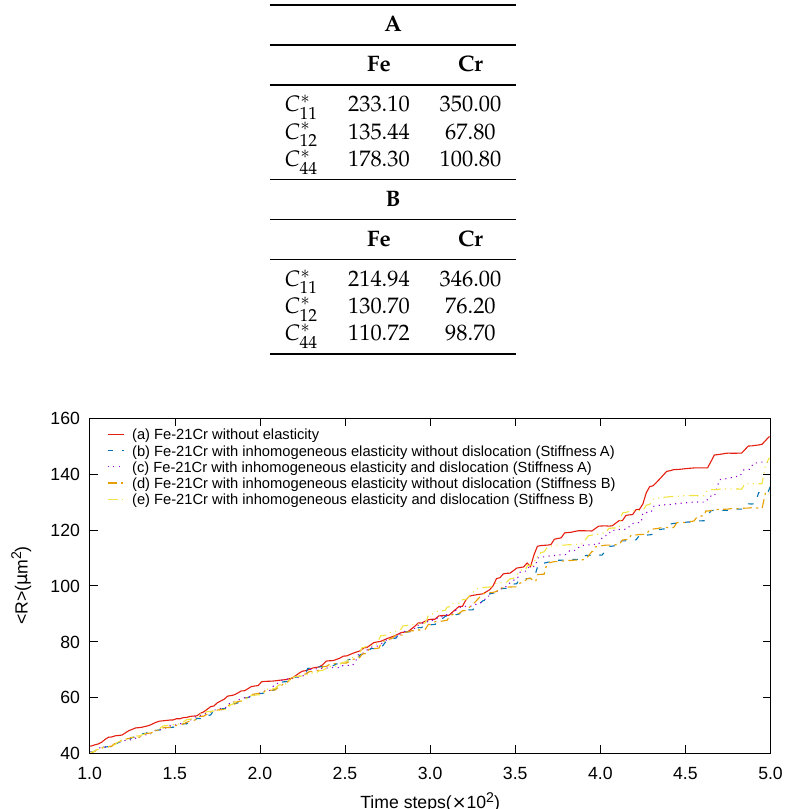
Table 1. The normalized stiffness tensor of Fe and Cr at 535K in Voigt notation [18–20].